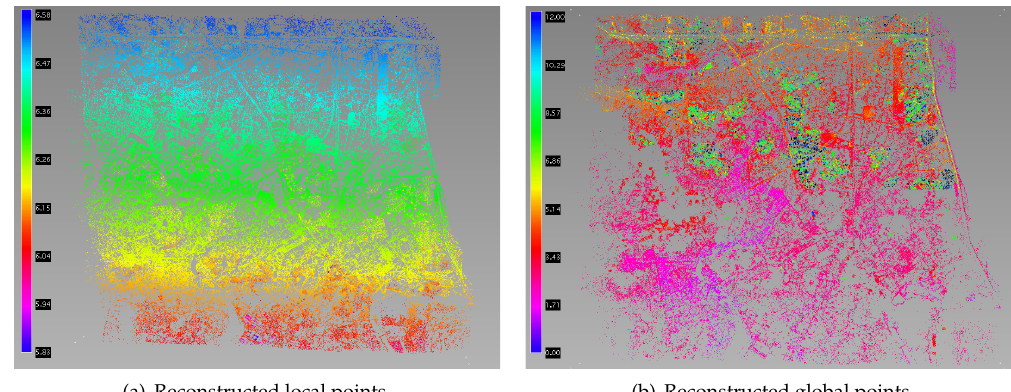
Figure 8. Reconstructed 3D terrain of the Village dataset in the local and global coordinate systems. The unit of measure of the reconstructed points in the global coordinate system is meters, whereas the local points have no practical meaning due to a lack of scale and origin information. ( a ) and ( b ) are 3D triangulated points of the Village dataset in the local and global coordinate systems, respectively.